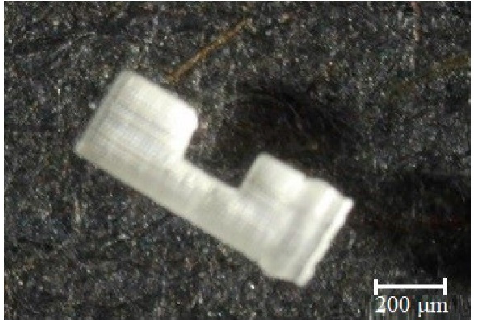
Figure 17. A micro-beam fabricated with DLP using clear IP-S resin photopolymer, where the smallest non-support feature is 86.7 µ m. Twenty supports with a diameter of 3 µ m were used during the building process. Here, the scale bar is 200 µ m [114].